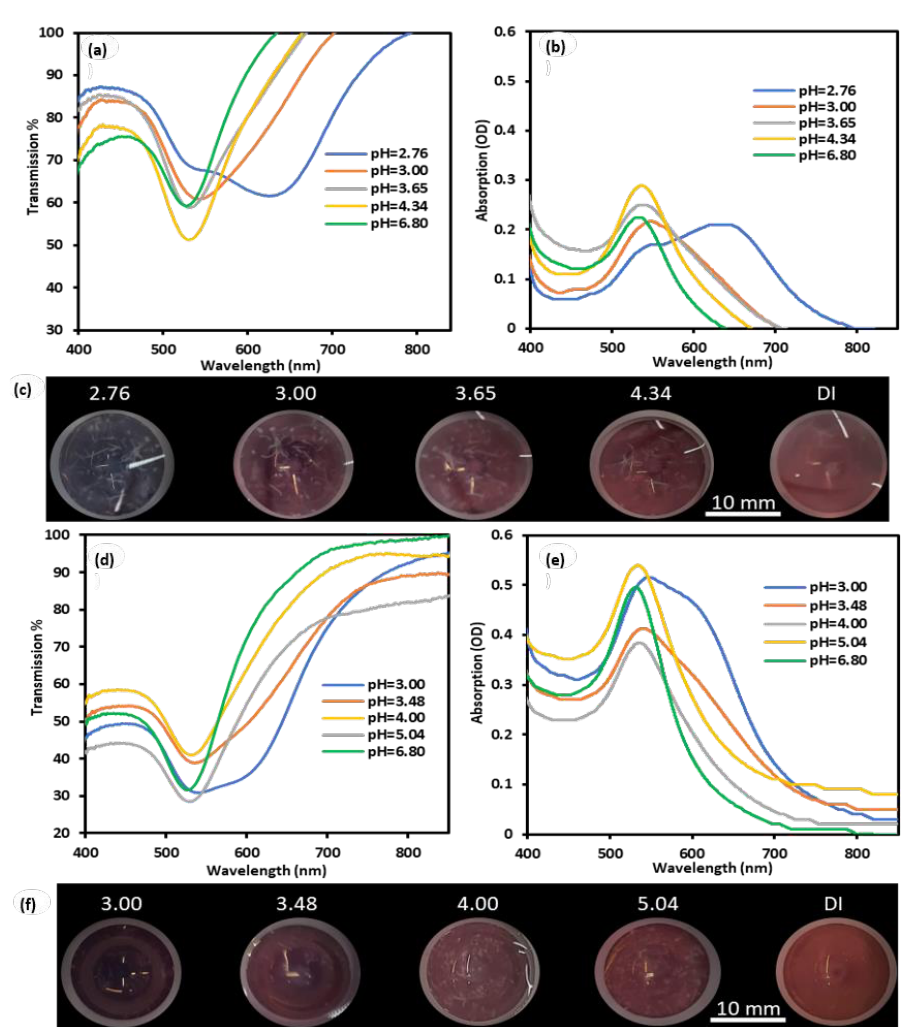
Figure 5. Optical properties of GNPs-MPA doped gels at different pHs: ( a ) Transmission, ( b ) absorption, and ( c ) images of a low concentrated gel (doped with 9 cycles) at different pHs. ( d ) Transmission, ( e ) absorption, and ( f ) images of high concentrated gel (doped with 15 BI-BO cycles) at distinct pH values.